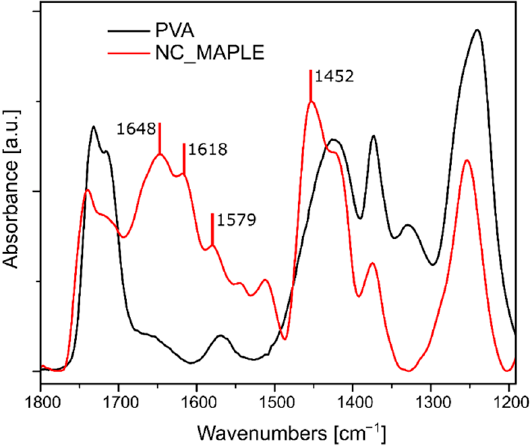
Figure 3. FTIR spectrum of NC deposited via MAPLE compared with the PVA spectrum.